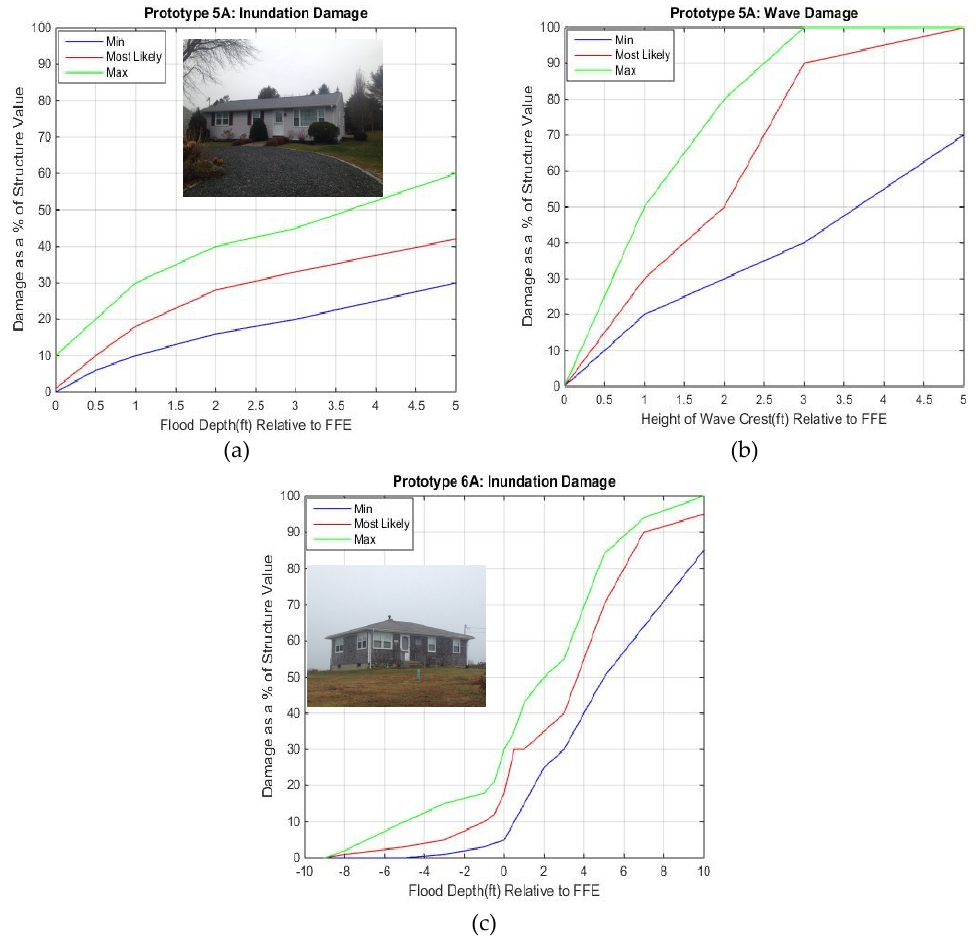
Figure 11 . Examples of damage functions proposed by the NACCS: ( a ) inundation damage to single story residences with no basement (prototype 5A); ( b ) wave damage to single story residences with no basement (5A); and ( c ) inundation damage to single story residences with a basement (6A). Inset photographs show 5A and 6A structures within the study area.